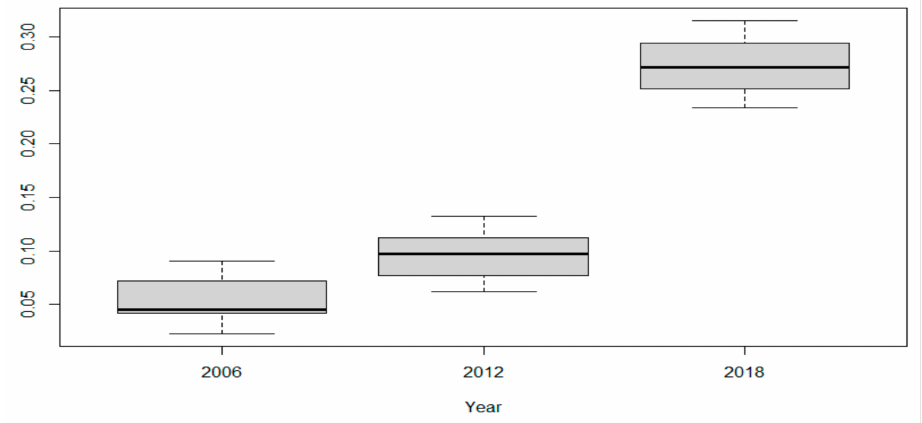
Figure 6. Development of waste sorting productivity.